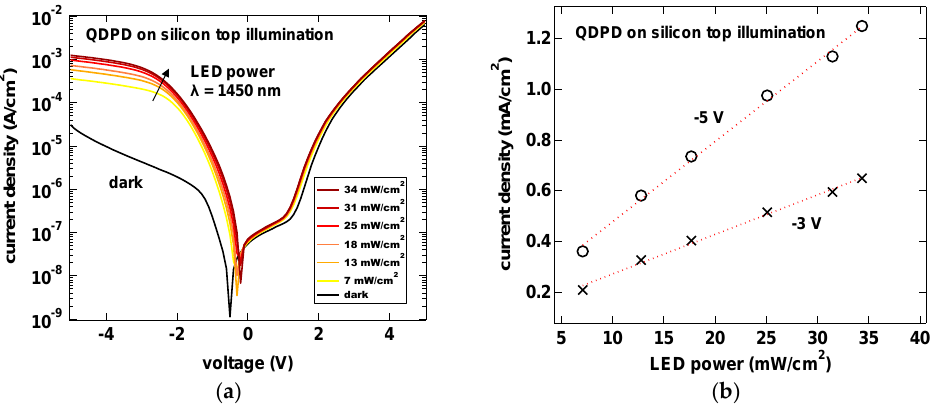
Figure 10. Current density—voltage characteristics ( a ) of a QDPD on Si substrate in dark (black line) and under 1450 nm IR LED with varying power (color lines); and linearity curve of the photocurrent density ( b ).